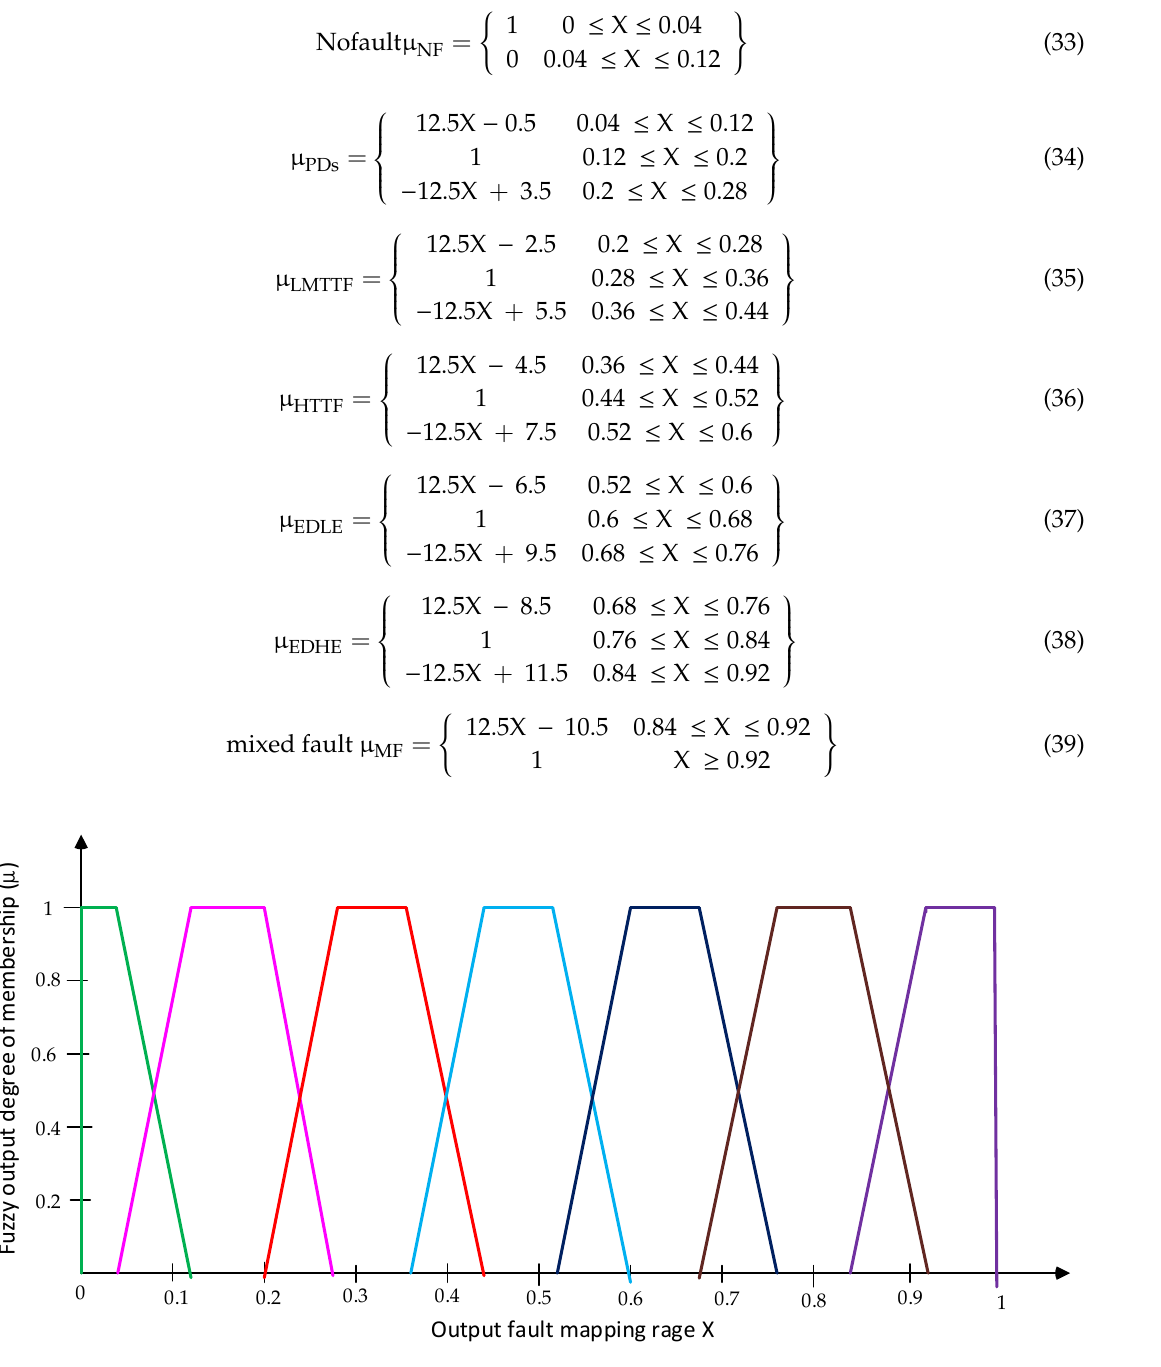
Figure 9. Functions used to defuzzify the degree of membership to crisp